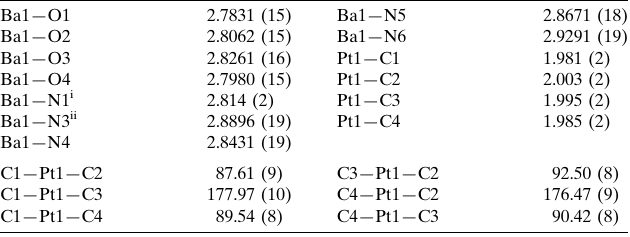
Selected geometric parameters (A˚ , (cid:2) ).